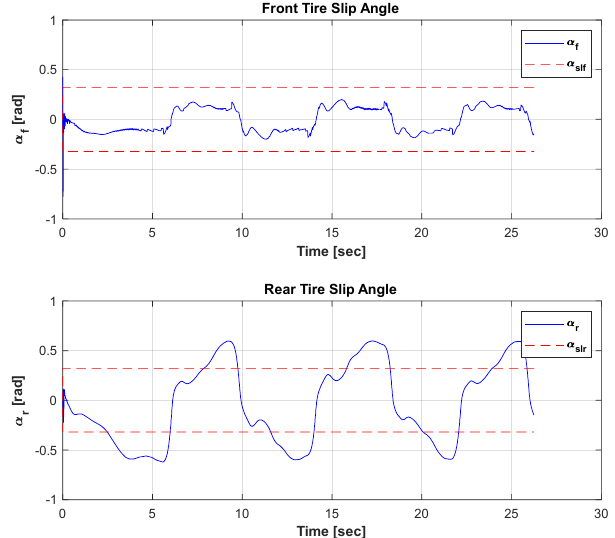
Figure 11. Front and rear tire slip angles of the vehicle during the drift maneuver. The solid blue curves in the upper and lower panels represent the front and rear tire slip angles of the vehicle, respectively, and the dotted red lines show the upper and lower saturation limits of the tires.